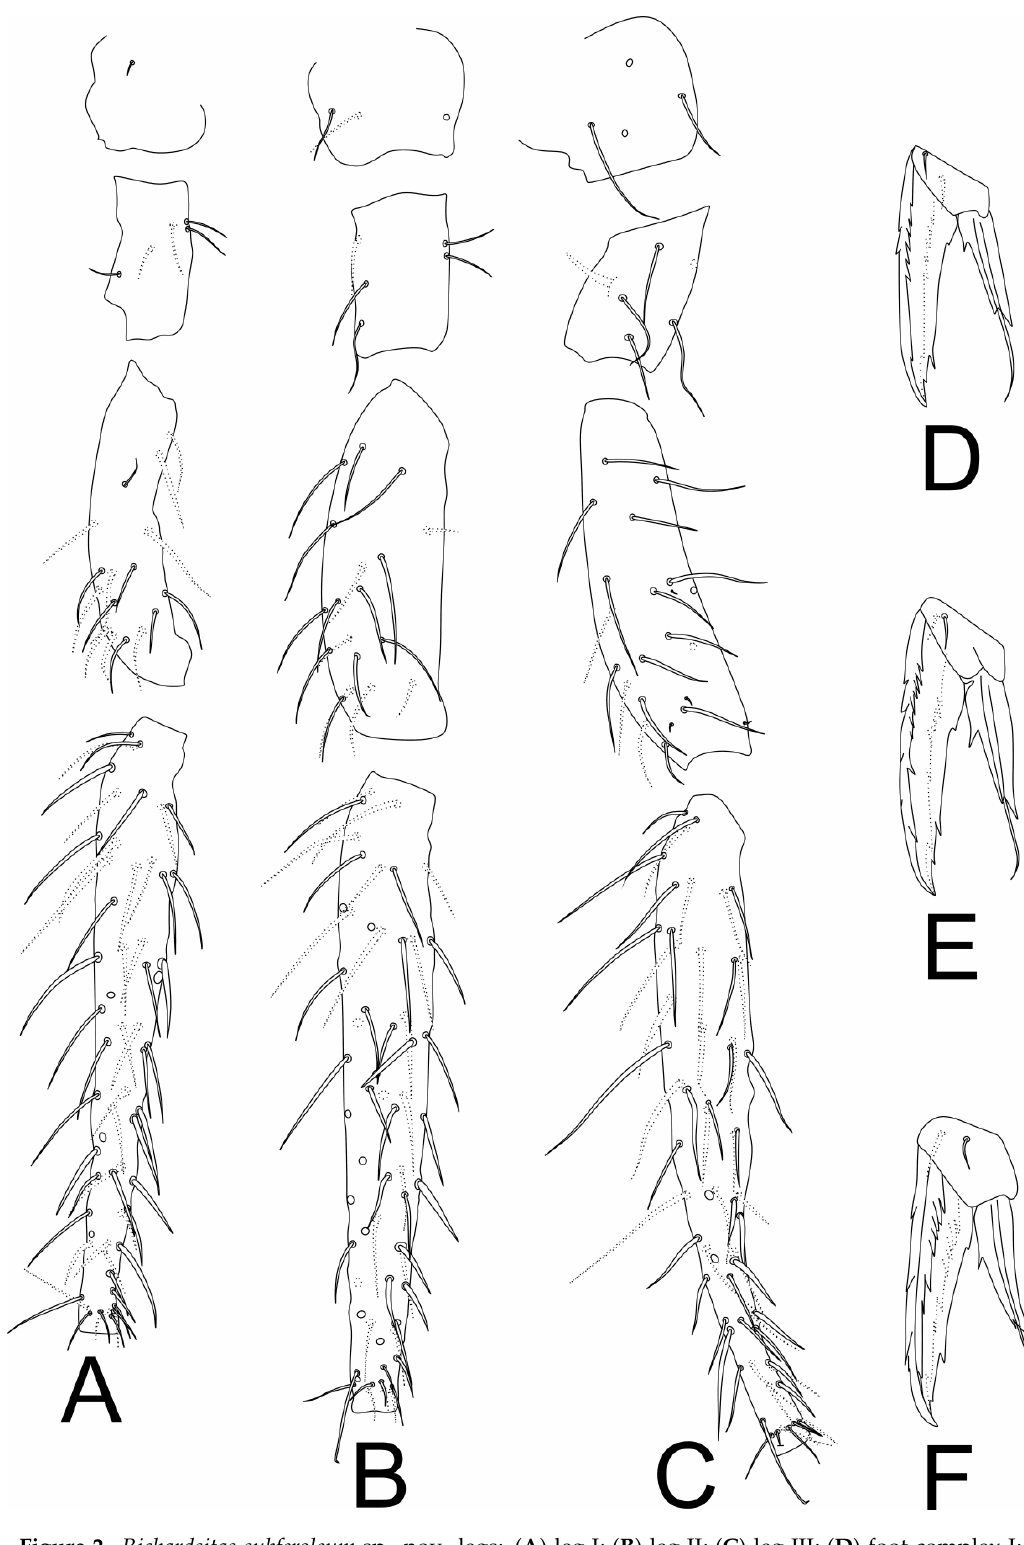
Figure 2. Richardsitas subferoleum sp. nov. legs: ( A ) leg I; ( B ) leg II; ( C ) leg III; ( D ) foot complex I; ( E ) foot complex II; ( F ) foot complex III.